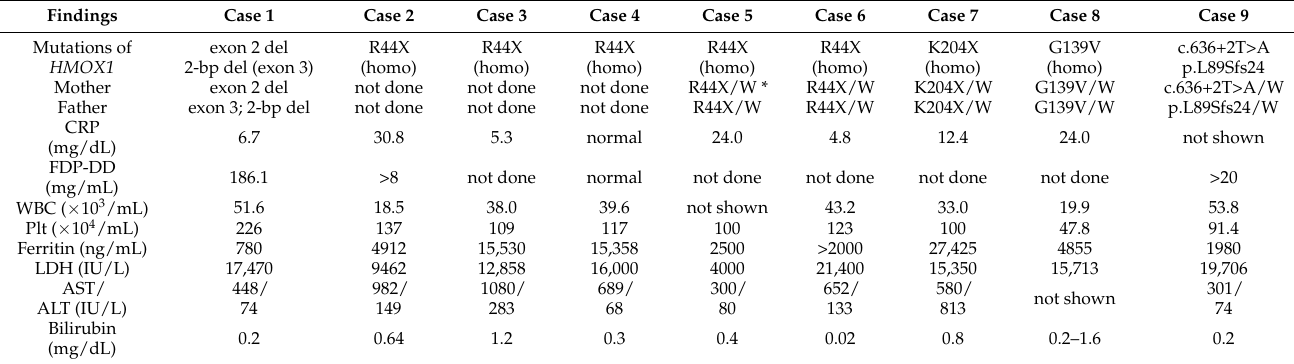
Table 2. Laboratory data of human HO-1 deficiency with null mutations of